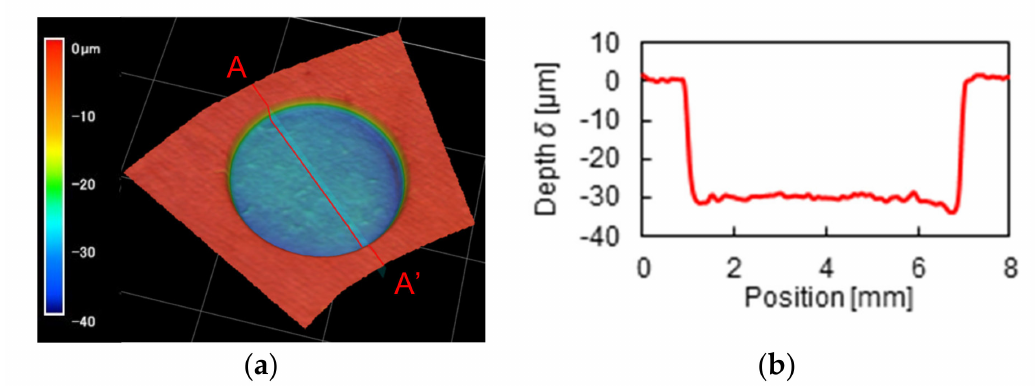
Figure 4. Microscope image of dimples used in this study: ( a ) 3D profile of a dimple, ( b ) Cross-sectional profile on A-A (cid:48) .